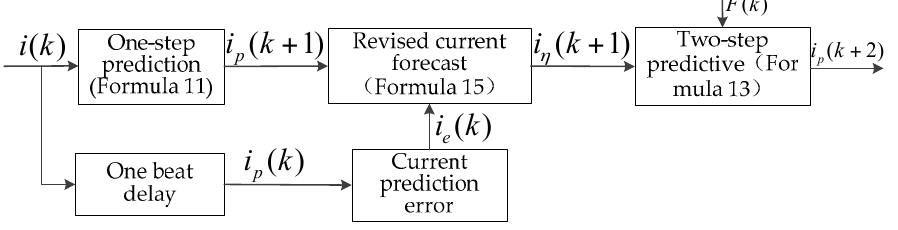
Figure 2. Block diagram of improved deadbeat current prediction control.